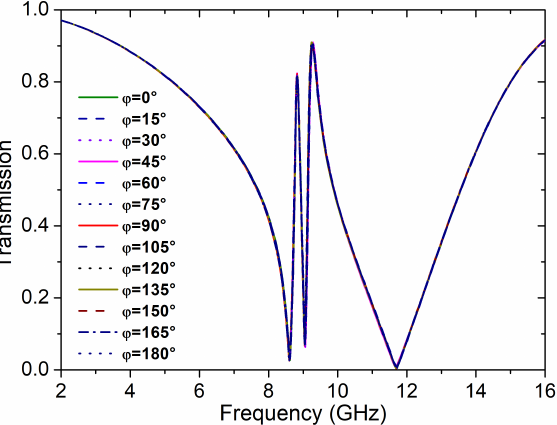
Figure 6: Transmission spectra of the proposed dual-band polarization independent EIT-like metamaterial for various polarization angles.